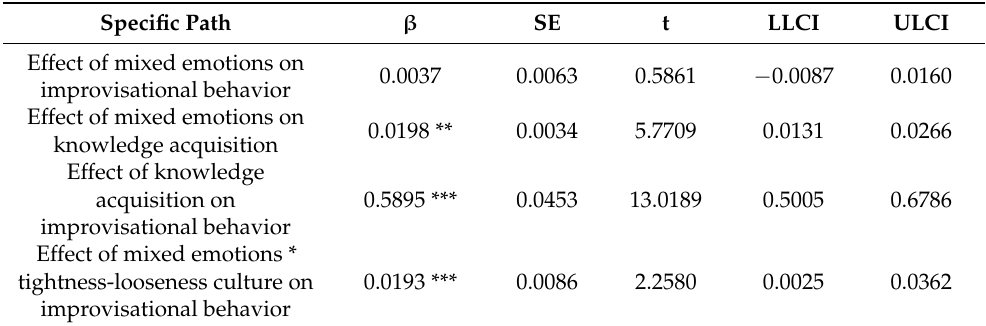
Table 3. Model path effects table.